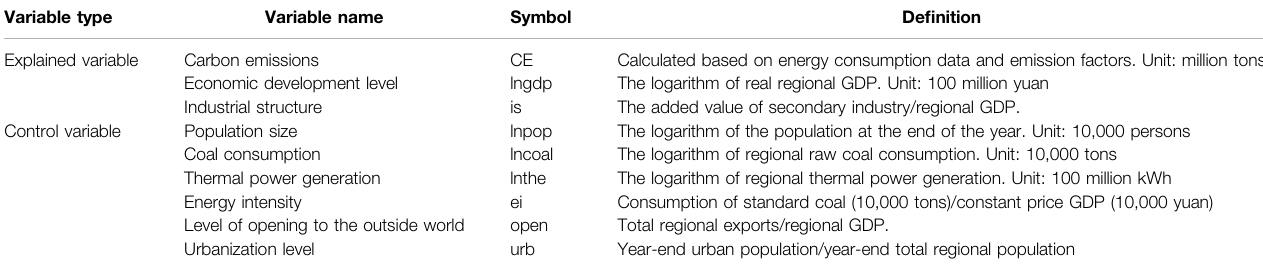
TABLE 1 | Main indexes and calculation methods of synthetic control method research. Variable type